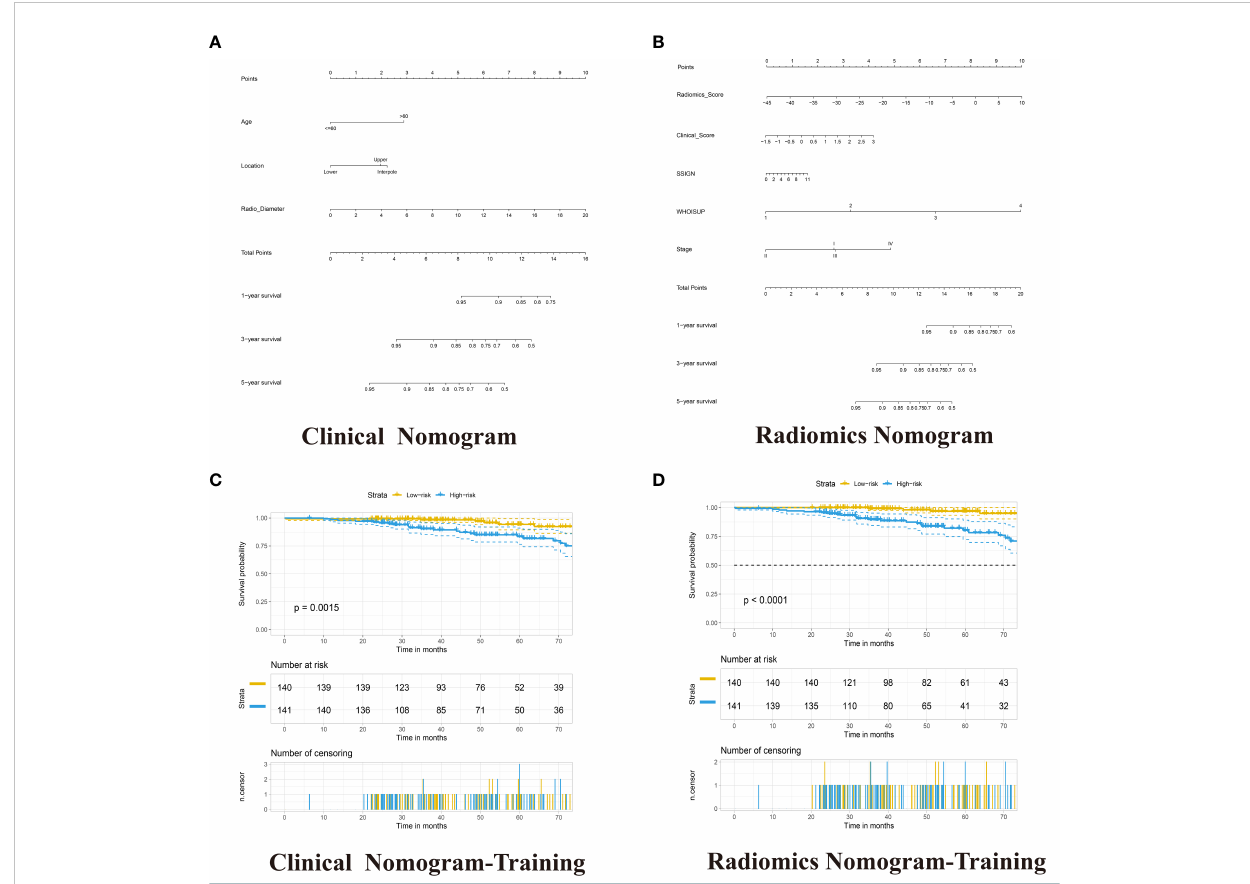
FIGURE 5 Development of the Clinical Nomogram and Radiomics Nomogram. (A) Nomogram for predicting the ratio of RCC patients with a certain survival time incorporating Age-level, Location and Radio-diameter in the training cohort. (B) Nomogram for predicting the ratio of RCC patients with a certain survival time incorporating Clinical score, SSIGN, TNM Stage, WHOISUP and radiomics signature in the training cohort. (C, D) Kaplan – Meier analysis of overall survival curves of High- and Low- Clinical or Radiomics nomogram in training group.